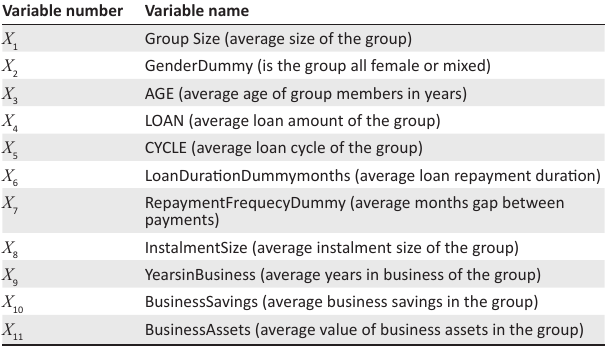
TABLE 2: Marginal effects of the probit model on the micro-credit programme.